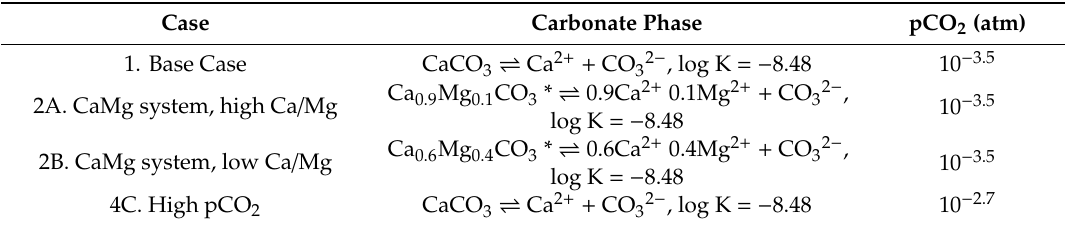
Table 2. Hypothetical PHREEQC models examining U sorption behavior as a function of